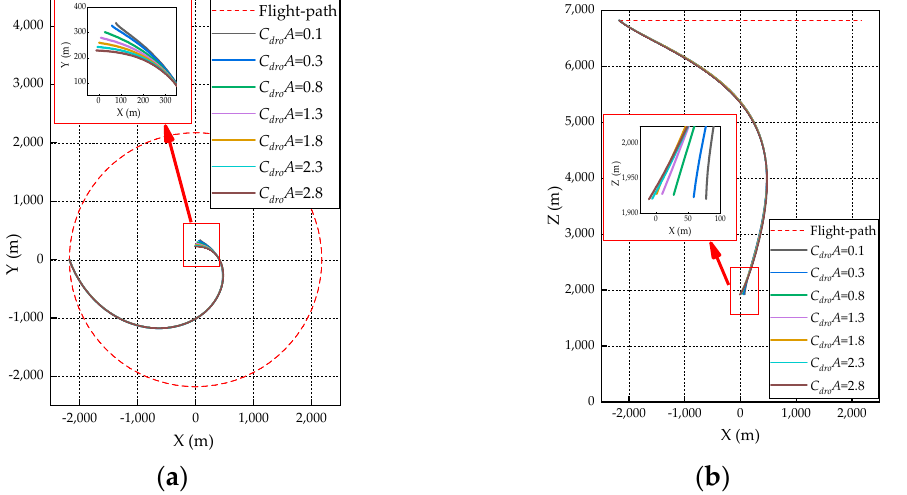
Figure 4. Towline spatial configurations vs. drogue drag characteristic: ( a ) Two-dimensional projection in horizontal plane; ( b ) Two-dimensional projection in vertical plane.